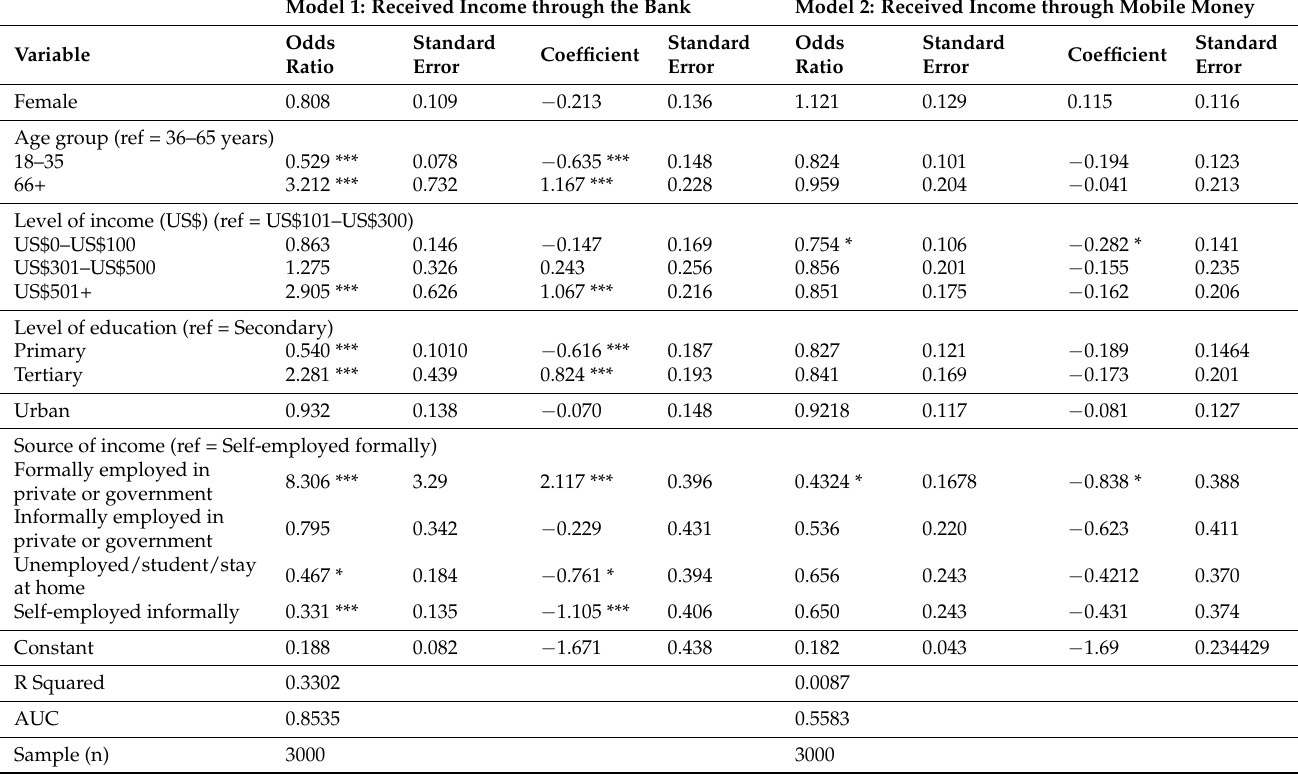
Table 3. Factors associated with receiving income through digital means (bank or mobile money). Model 1: Received Income through the Bank Model 2: Received Income through Mobile